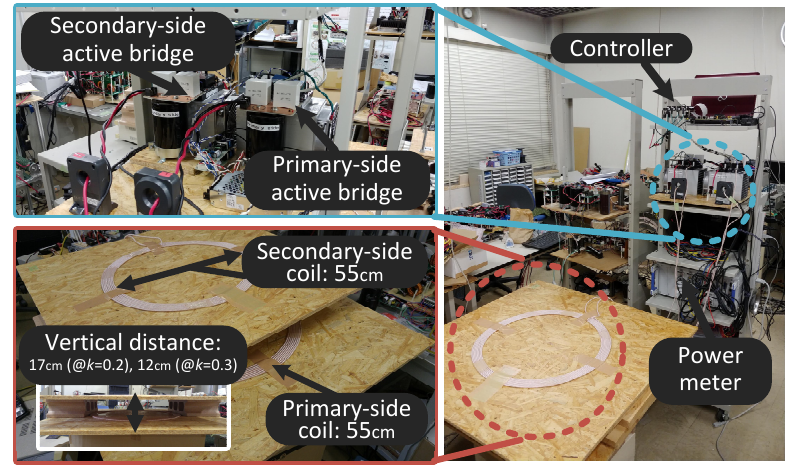
Figure 7. The appearance of the experimental